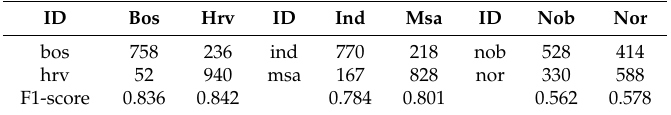
Table 15. Confusion matrix and F1-scores related to similar languages in two-stage